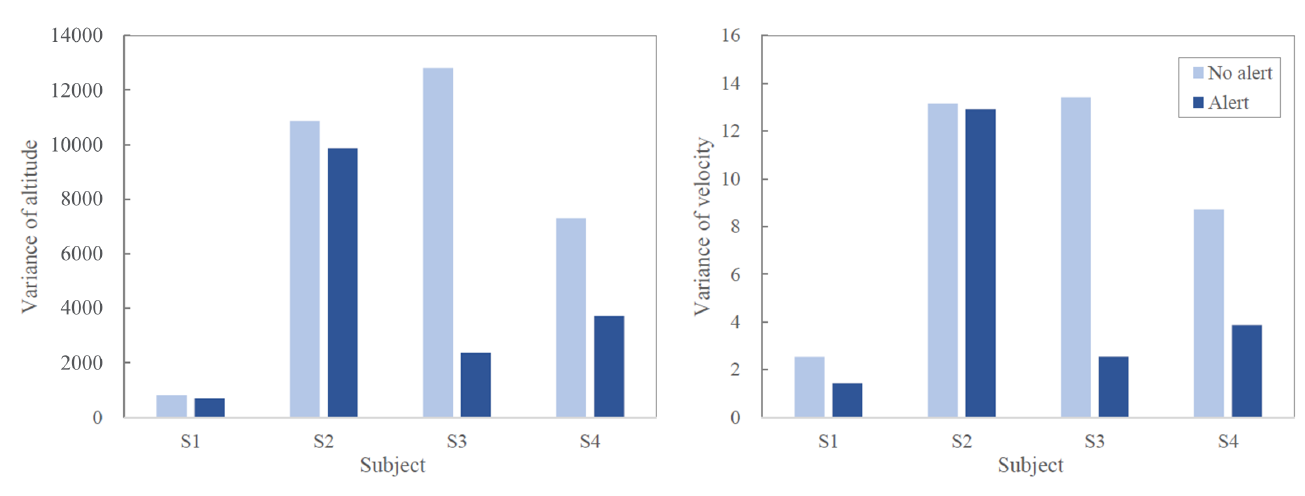
Figure 14. Variances of two performance values, altitude ( left ) and velocity ( right ), for two situations, when alert is provided or